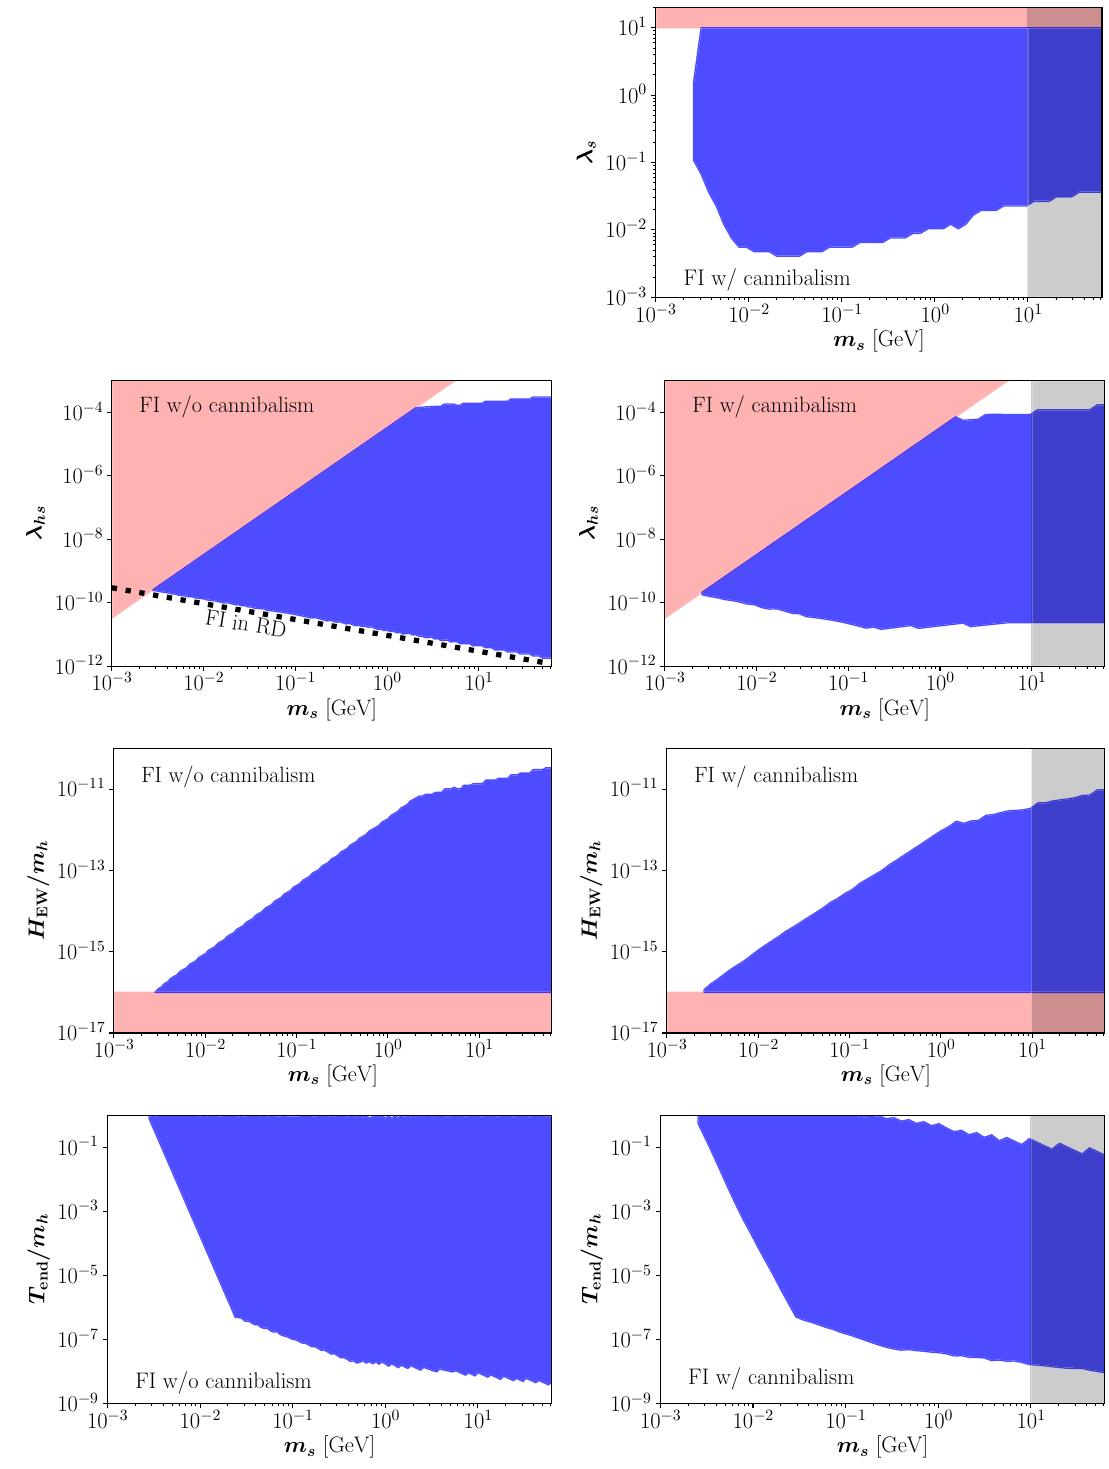
Fig. 7 DM freeze-in without (left column) and with (right column) cannibalism.ParameterspacegivingrisetotheobservedDMrelicabun- dance. The black dotted line shows the parameters yielding the correct DM abundance in the usual RD scenario. The red regions correspond to the constraints discussed in Sect. 2.2: the SM temperature after the matter-like component has decayed into SM particles must be larger